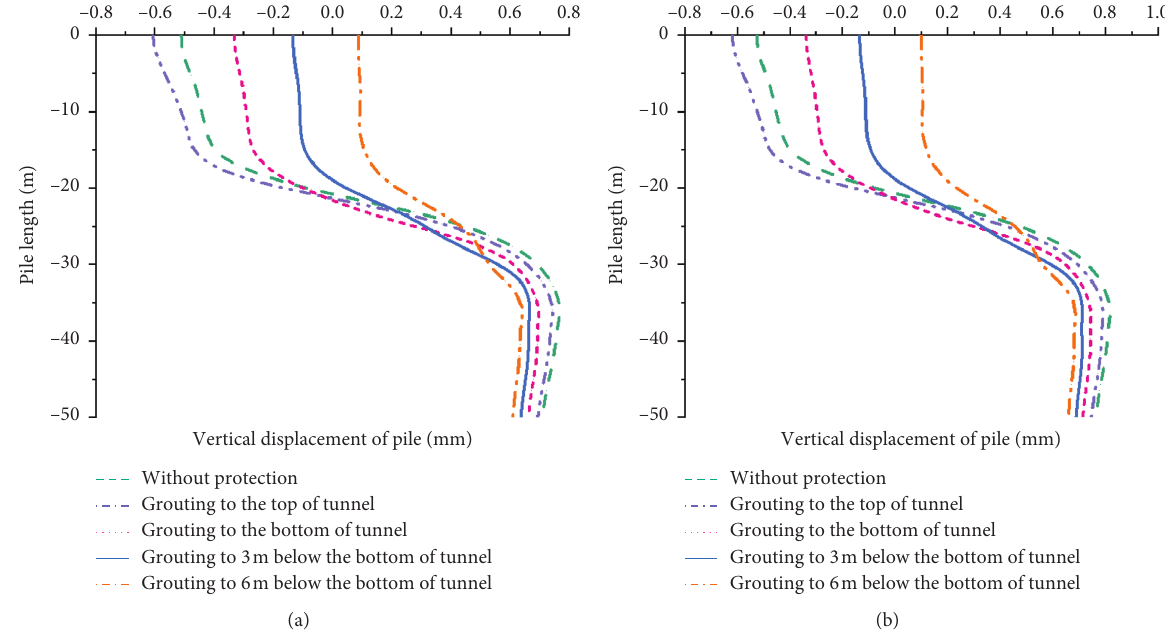
Figure 9: Vertical displacement of the pile: (a) 6 rings after passing the pile; (b) 8 rings after passing the